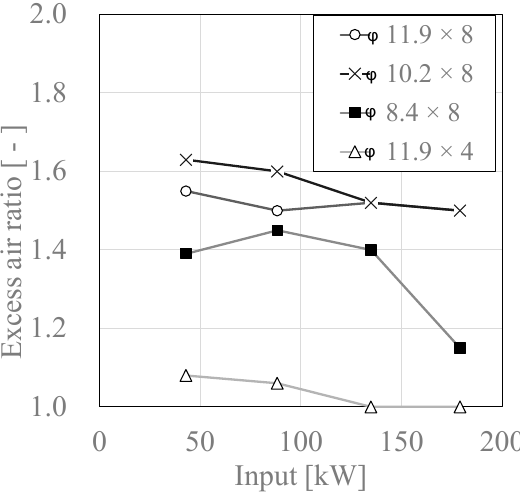
Figure 4. Combustion stability range (CO < 100 ppm) for different combustion rates under each air nozzle case, at 723 K, P = +15 Pa and E H2 = 0%.